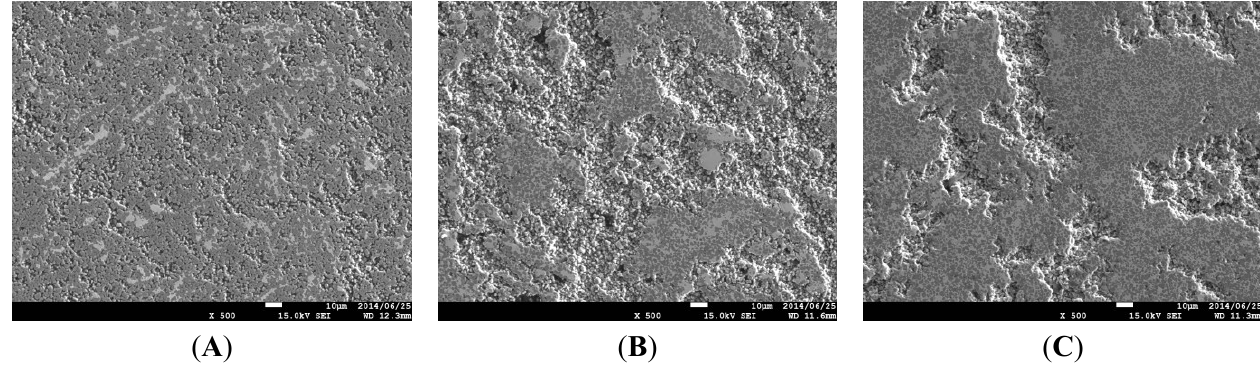
Figure 3. SEI of the TiB 2 -Cu cermets with various copper content after Spark Plasma Sintering (SPS) at 1100 °C: ( A ) TiB 2 -10 vol. % Cu; ( B ) TiB 2 -20 vol. % Cu, ( C ) TiB 2 -30 vol. % Cu.